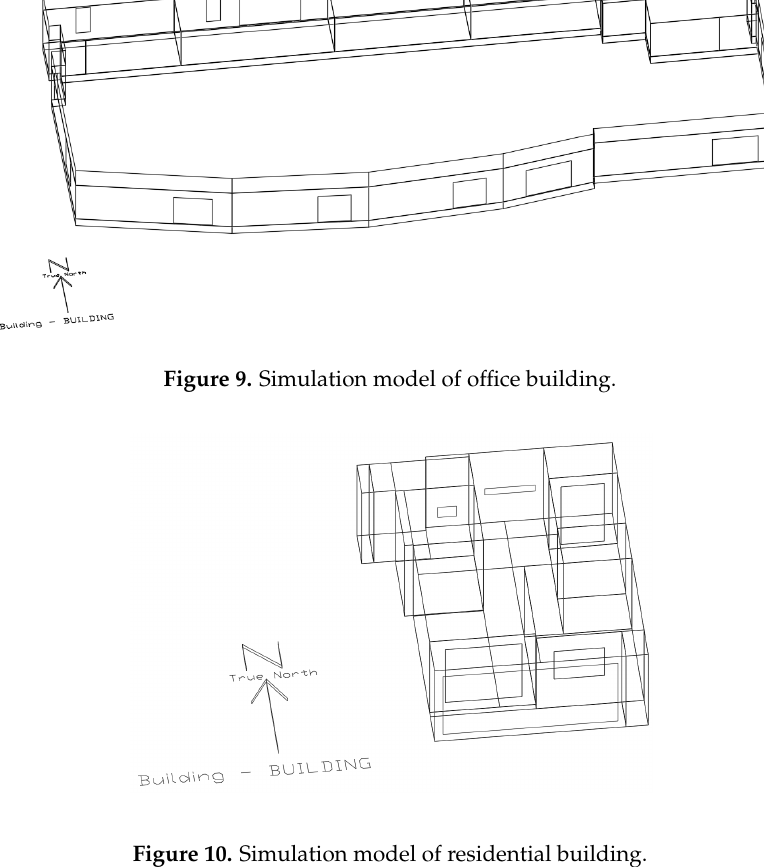
Figure 10. Simulation model of residential building.